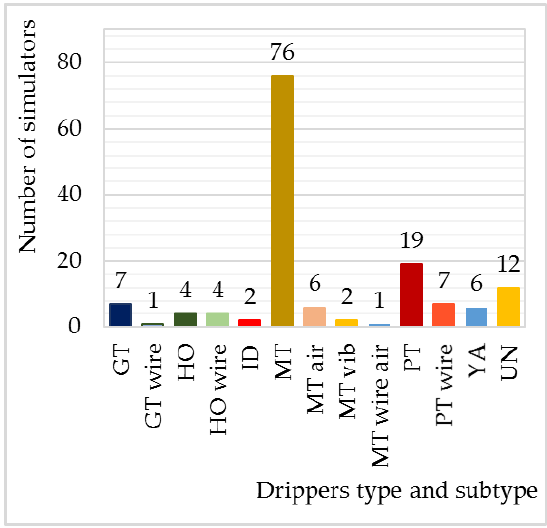
Figure 14. Number of different simulators with drippers of a certain type and subtype. Note: the analysis also includes individual simulations with different types of drippers of one simulator.